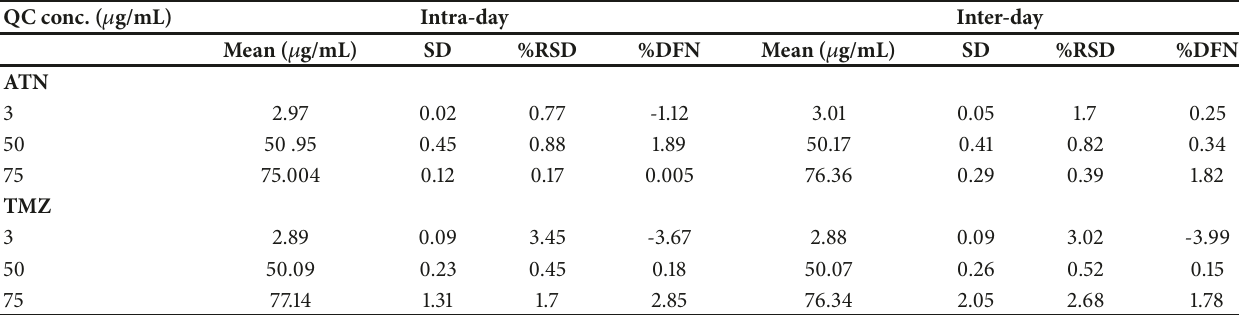
∗ Figures between parenthesis represent the corresponding tabulated values of t and F at P= 0.05. ∗∗ Table 4: Intra- and interday precision and accuracy calculated from quality control (QC) samples in pure form. QC conc. ( 𝜇 g/mL)